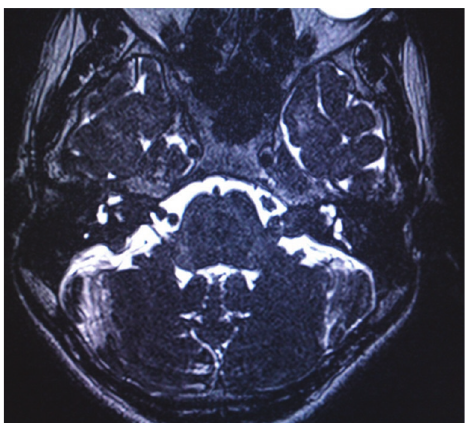
Figure 3: Axial constructive interferance in steady state MR image showing bilateral acoustic schwannomas with internal auditory meatus widening and CP angle cisternal extension.